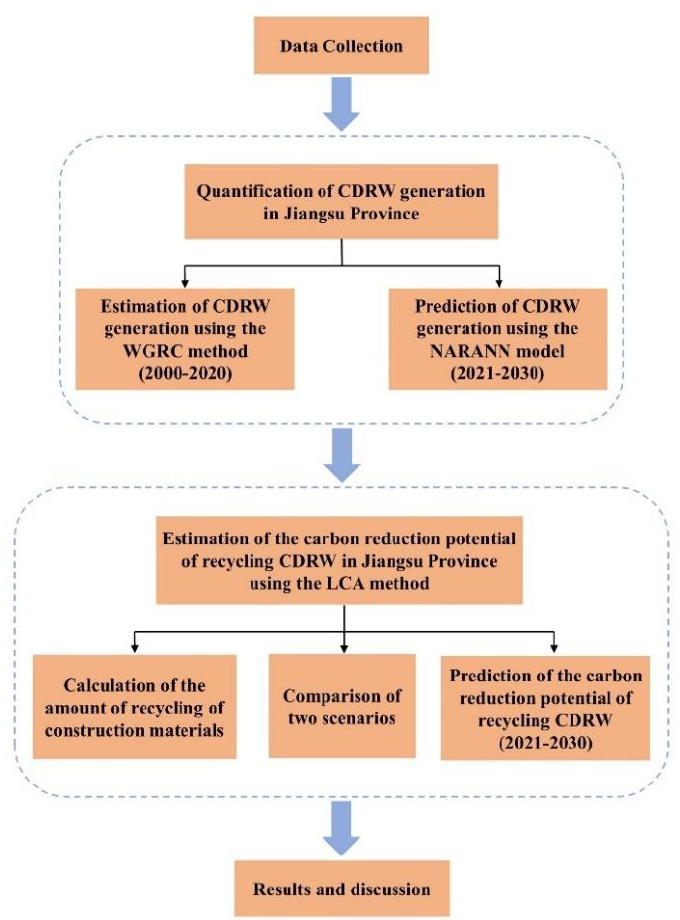
Figure 1. The flow chart of this study (WGRC: waste generation rate calculation; NARANN: nonlinear autoregressive artificial neural network).